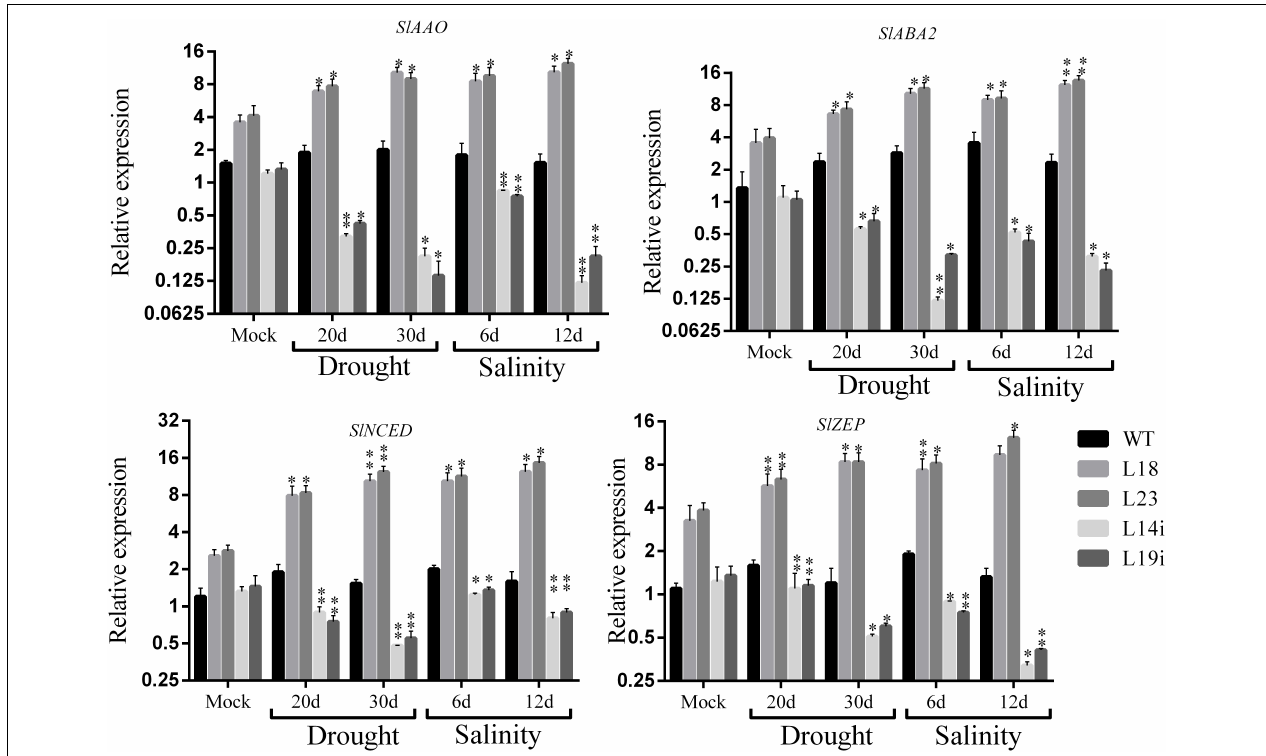
FIGURE 6 | Expression profile of ABA biosynthesis related genes in WT and transgenic lines (L18 and L23) under drought and salinity. Data represent mean of ± SE for three independent biological replicates ( n = 3). ∗ and ∗∗ represent the significant difference as determined by t -test ( P -value ≤ 0.01 ∗∗ /0.05 ∗